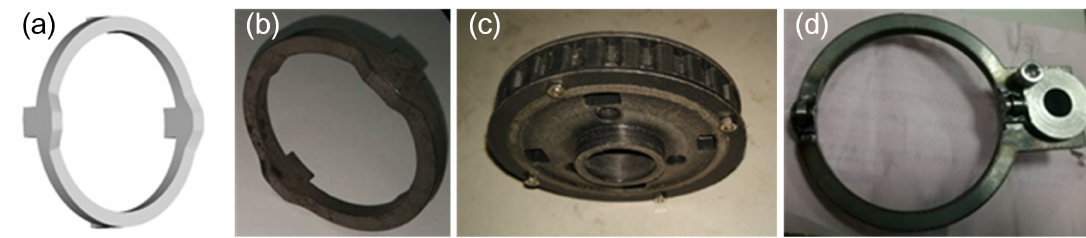
Figure 14. ( a , b ) show the 3D model and prototype switch cam (Part 4 (cid:13) ), ( c ) shows the switch pulley (Part 2 (cid:13) ) and ( d ) shows the cam follower (Part 5 (cid:13) ).